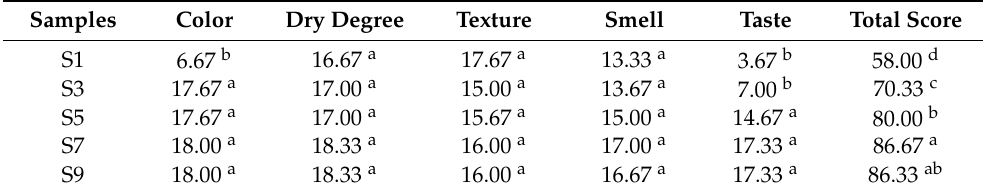
Table 1. Sensory scores of samples during the